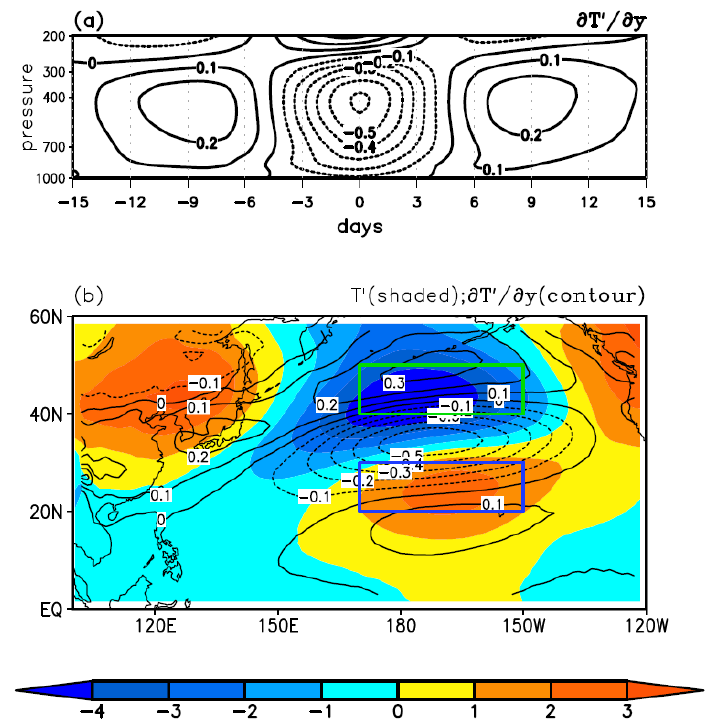
Figure 5. The time-altitude profile of the 10–40-day filtered temperature gradient in the jet exit re- gion ( a , unit: 10 − 5 °C/m), the 10–40-day filtered temperature ( b , shaded, unit: °C), and the 10–40-day filtered temperature gradient ( b , contoured, unit: 10 − 5 °C/m) synthesized on the peak day, integrated from the surface to 300 hPa. The green box represents the area north of the jet exit region (170° E–150° W, 40–50° N); the blue box represents the south of the jet exit region (170° E–150° W, 20°–30° N).